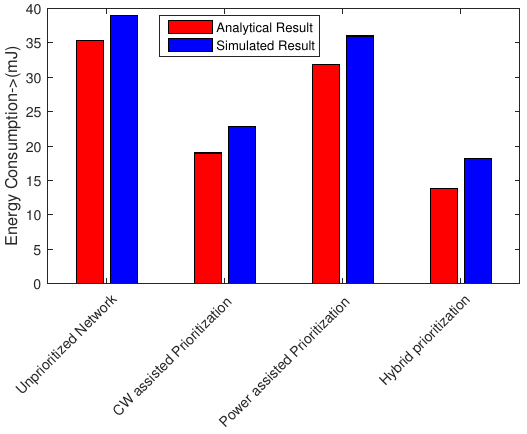
Figure 23. Average network energy consumption.